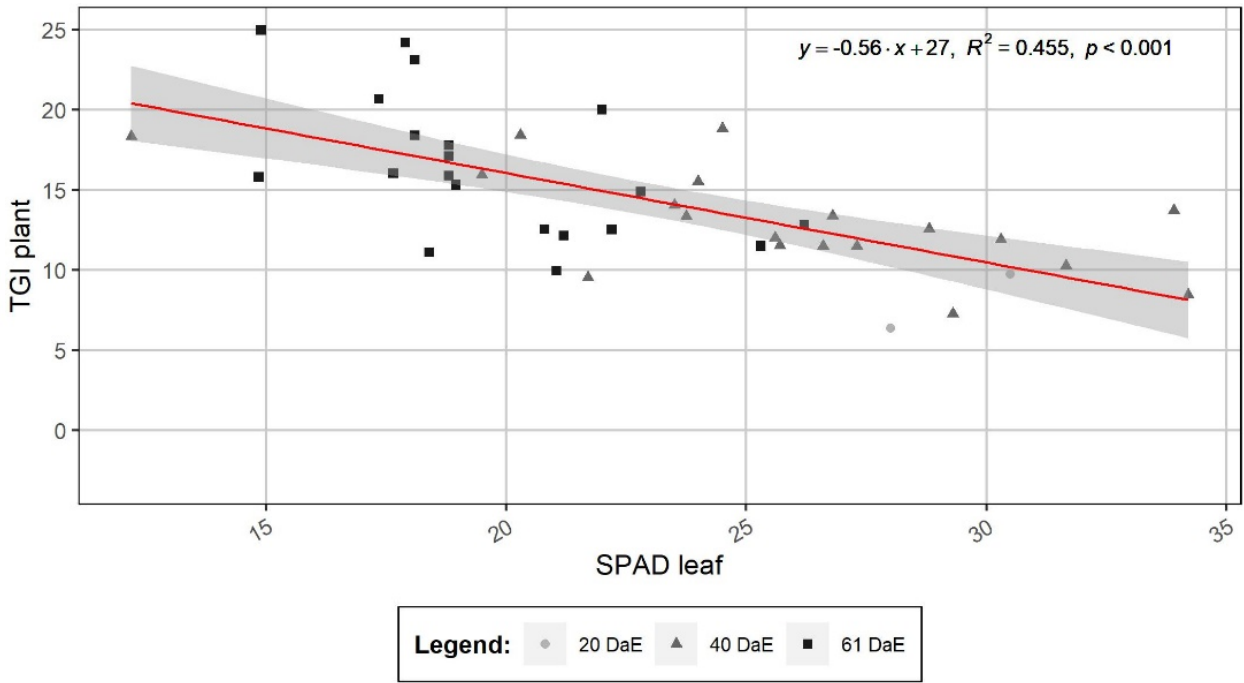
Figure 5. Relationship between the SPAD value measured on the 7th fully developed leaf starting from the apex of the main vine and the plant TGI value averaged for all leaves at 20, 40 and 61 days after emergence, DaE) in a greenhouse experiment conducted with water yam cv raja ala grown in the presence of different N fertilizations. Each dot represents the value for one plant ( n = 42 plants). The form of the symbols indicates the sampling dates, and the grey band indicates the 95% confidence interval.